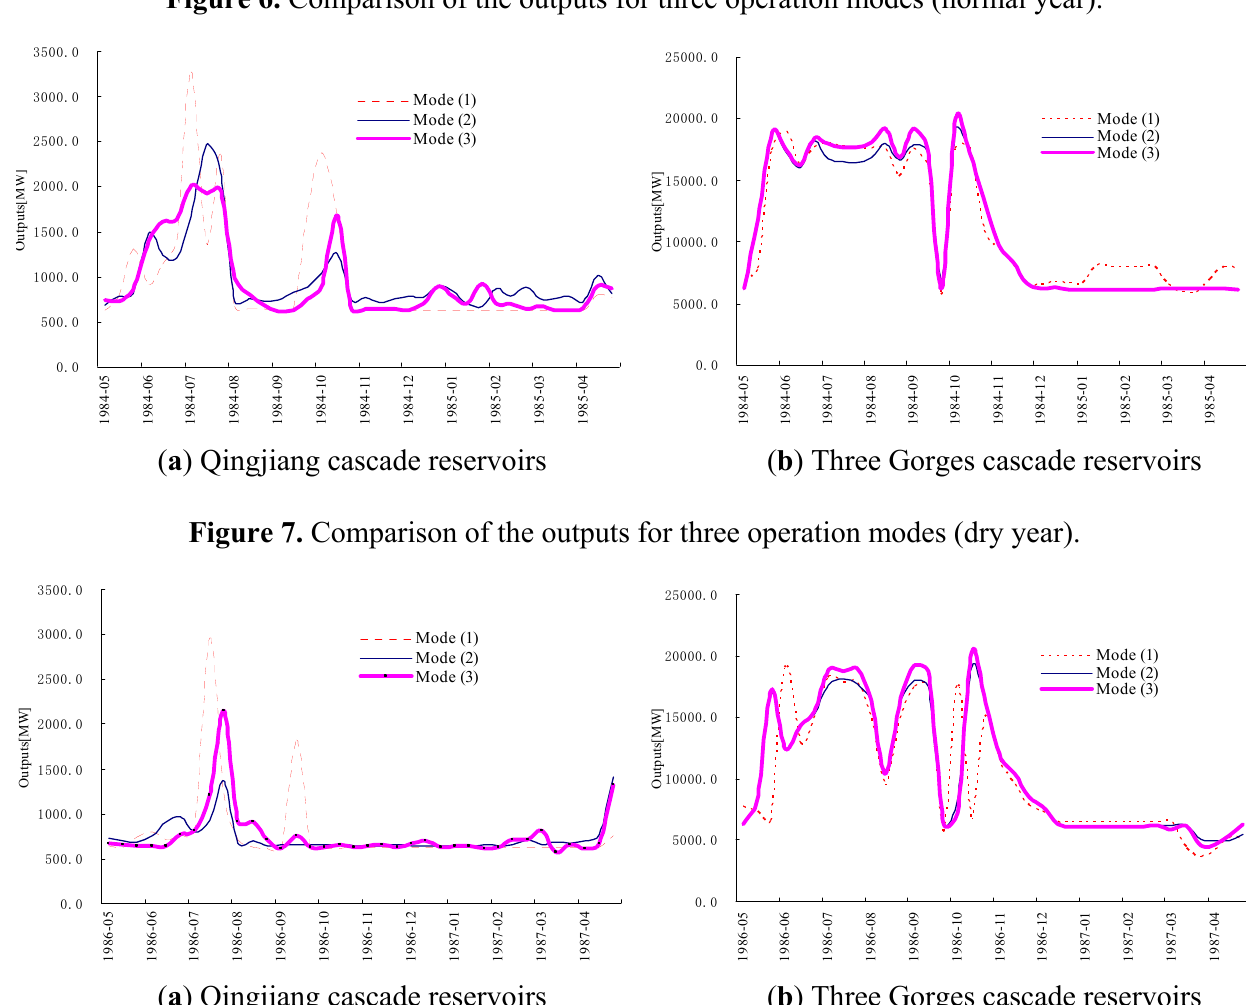
Figure 6. Comparison of the outputs for three operation modes (normal year).